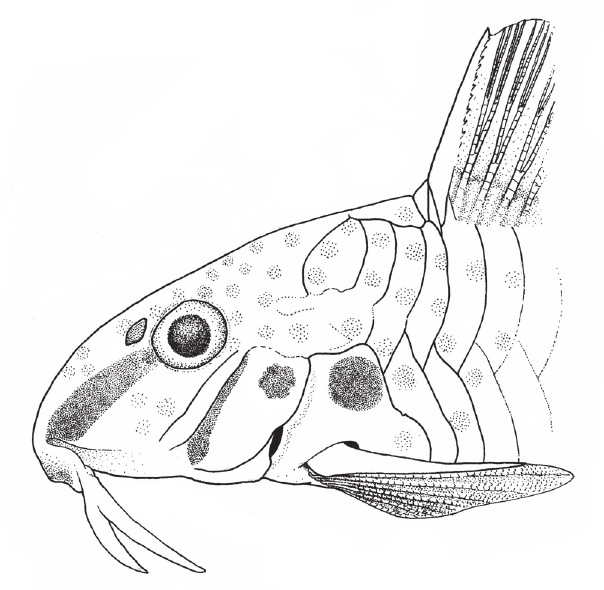
Fig. 4. Schematic drawing showing color pattern details in anterior portion of the body of Corydoras lymnades , based in a paratype, NUP 9965, 28.7 mm